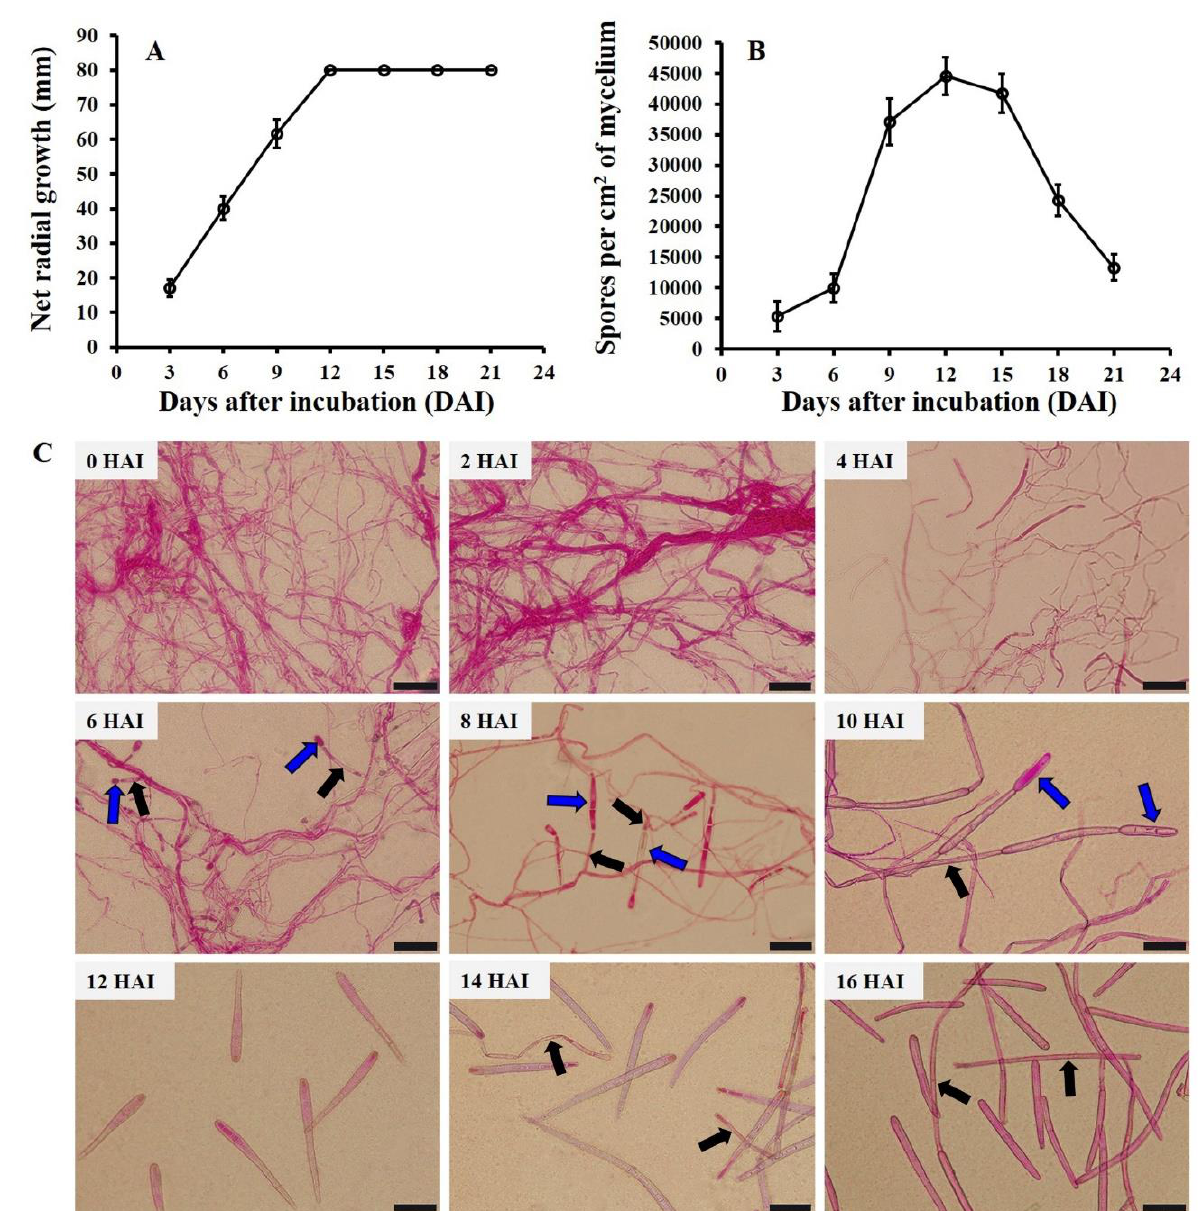
Figure 1. Radial growth ( A ) and sporulation production ( B ) of Corynespora cassiicola incubated on potato dextrose agar (PDA) at 28 °C in darkness and examined at 3, 6, 9, 12, 15, 18 and 21 days after incubation (DAI). Radial growth was measured on two perpendicular axes for each plate. The spores were counted using a whole mycelium harvest technique by a hemocytometer. Data points are the means of three replicates, and error bars represent standard deviations. ( C ) Sporulation dynamics of C . cassiicola on cucumber seedlings incubated at 28 °C and 100% RH in darkness and examined at 0, 2, 4, 6, 8, 10, 12, 14, and 16 h after incubation (HAI). Spores were collected by placing Scotch tape on the surfaces of cucumber leaves (upper and lower sides). Blue arrowheads indicate the spores remain on the conidiophores. Black arrowheads indicated the conidiophores (Scale bars, 50 μm).